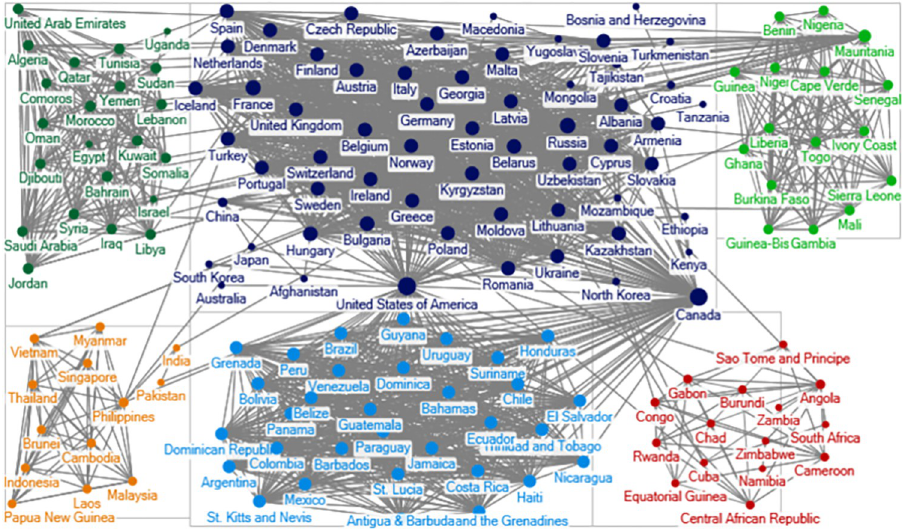
Fig 2. Political alliance network in 2000. A node is a state name. Ties connecting nodes represent political alliance relationship. The lines are undirected. Greater size of the notes indicates that the states have more political alliance ties.